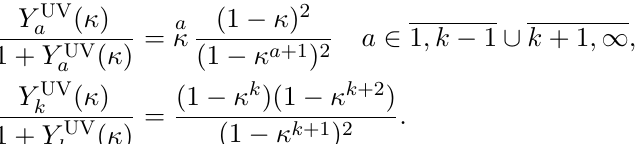
Again we choose a cut-o(cid:11) on SU(2) magnon string length of 30. This gives (cid:12)ve digit precision for values of the twist parameter smaller than 1 =